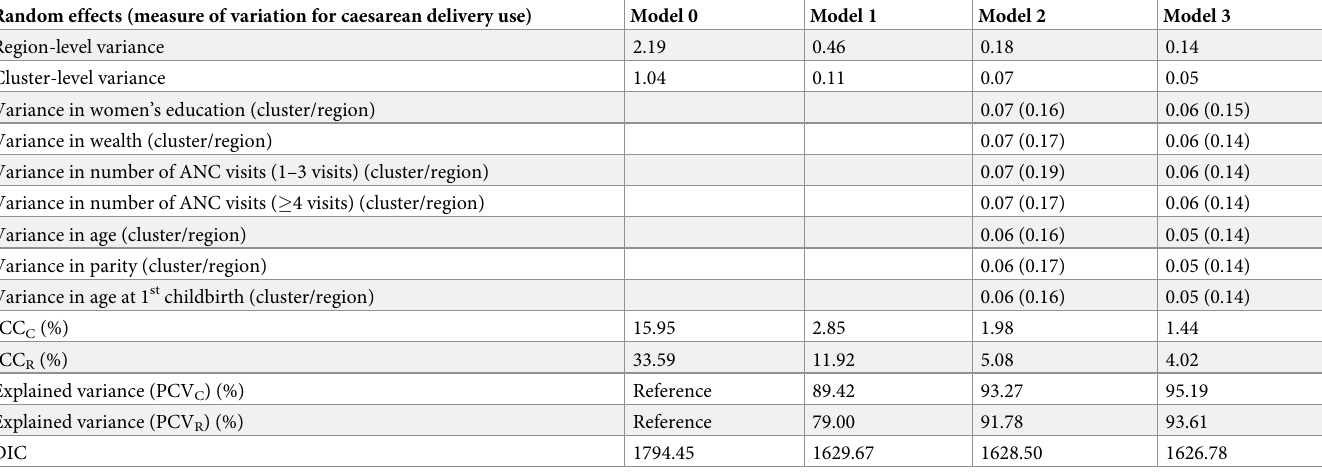
Table 2. Variations in caesarean delivery use in Ethiopia: Random slope and random intercept model.